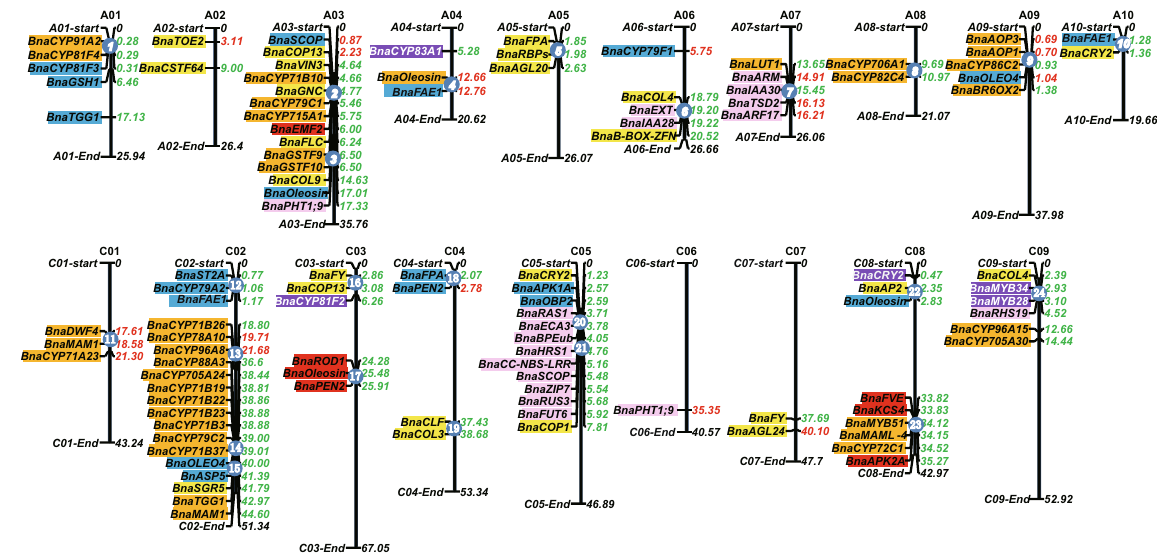
Figure 7. The distribution of gene clusters controlling important agronomic traits located on the physical map of B. napus . Key genes controlling flowering time (yellow boxes), seed oil content (blue boxes), seed glucosinolate content (orange boxes), seed erucic acid content (red boxes), seed protein content (purple boxes), and root morphological traits (pink boxes) detected within QTL regions in the Bna TNDH mapping population plotted on the 19 chromosomes of Darmor- bzh . Numbers to the right of each chromosome indicate the position of beneficial alleles from the Tapidor pedigree (red) or the Ningyou7 pedigree (green). The blue disc with white numbers on chromosomes indicates the gene clusters of important agronomic traits in the two cultivar